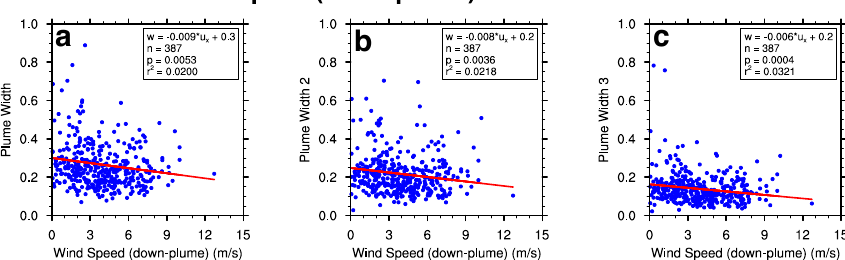
Fig. 8. Linear regression of cross-plume width w and down-plume wind speed u x (ms − 1 ) using three definitions of wind speed defined in Sect. 2.3.